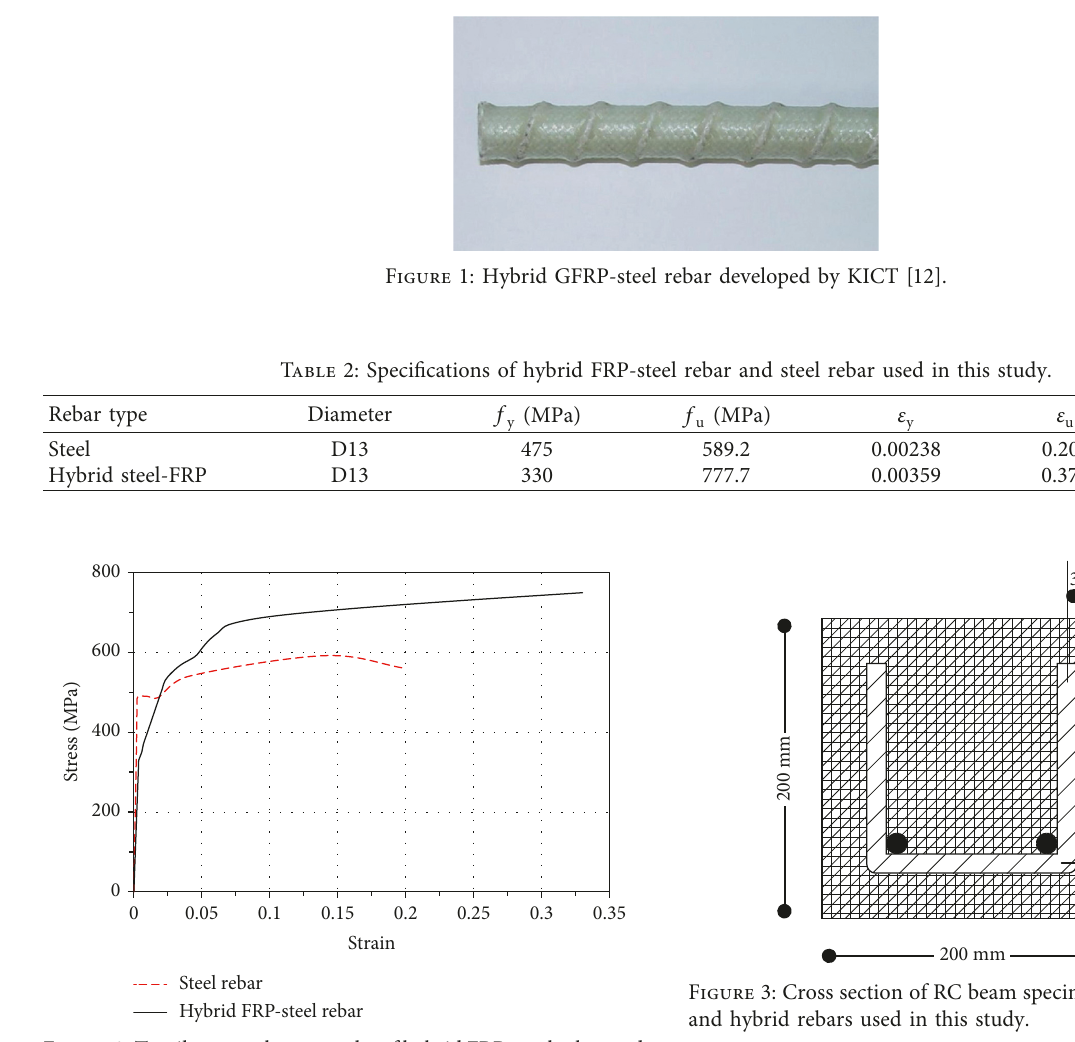
Figure 2: Tensile strength test results of hybrid FRP-steel rebar and steel rebar used in this study. Table 3 arranges the static test results for the RC beam specimens reinforced by conventional D13 steel rebars (RC- SR) and RC beam specimens reinforced by D13 hybrid FRP- steel rebars (RC-HR). In Table 3, P